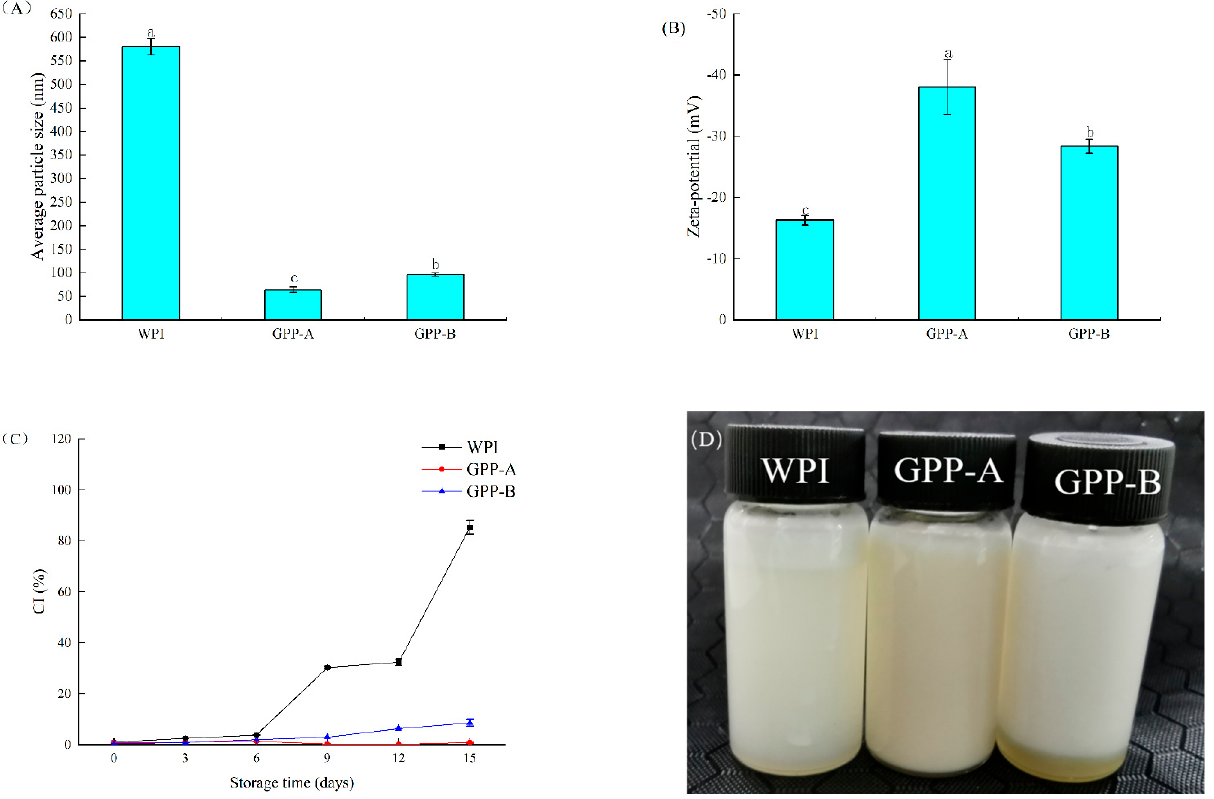
Figure 3. Changes in average particle size ( A ); zeta − potential ( B ); creaming index ( C ) and macro- scopic pictures when stored for 15 days at 25 ◦ C ( D ) of CLA emulsions stabilized by GPP-A and scopic pictures when stored for 15 days at 25 °C ( D ) of CLA emulsions stabilized by GPP-A and GPP-B. Values with different letters are significantly different ( p < GPP-B. Values with different letters are significantly different ( p < 0.05).